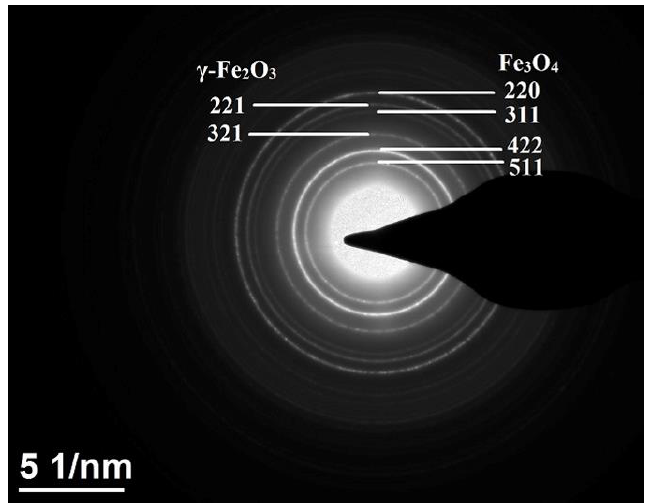
Figure 4. The selected area electron diffraction (SAED) pattern for sample S2.